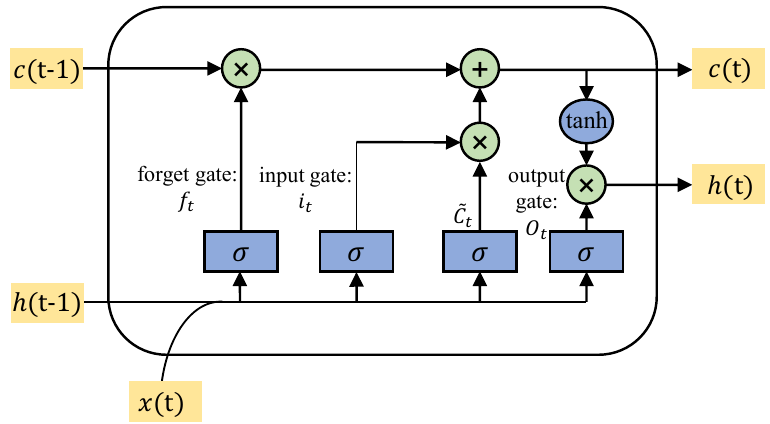
Figure 4. Schematic diagram of LSTM structure.